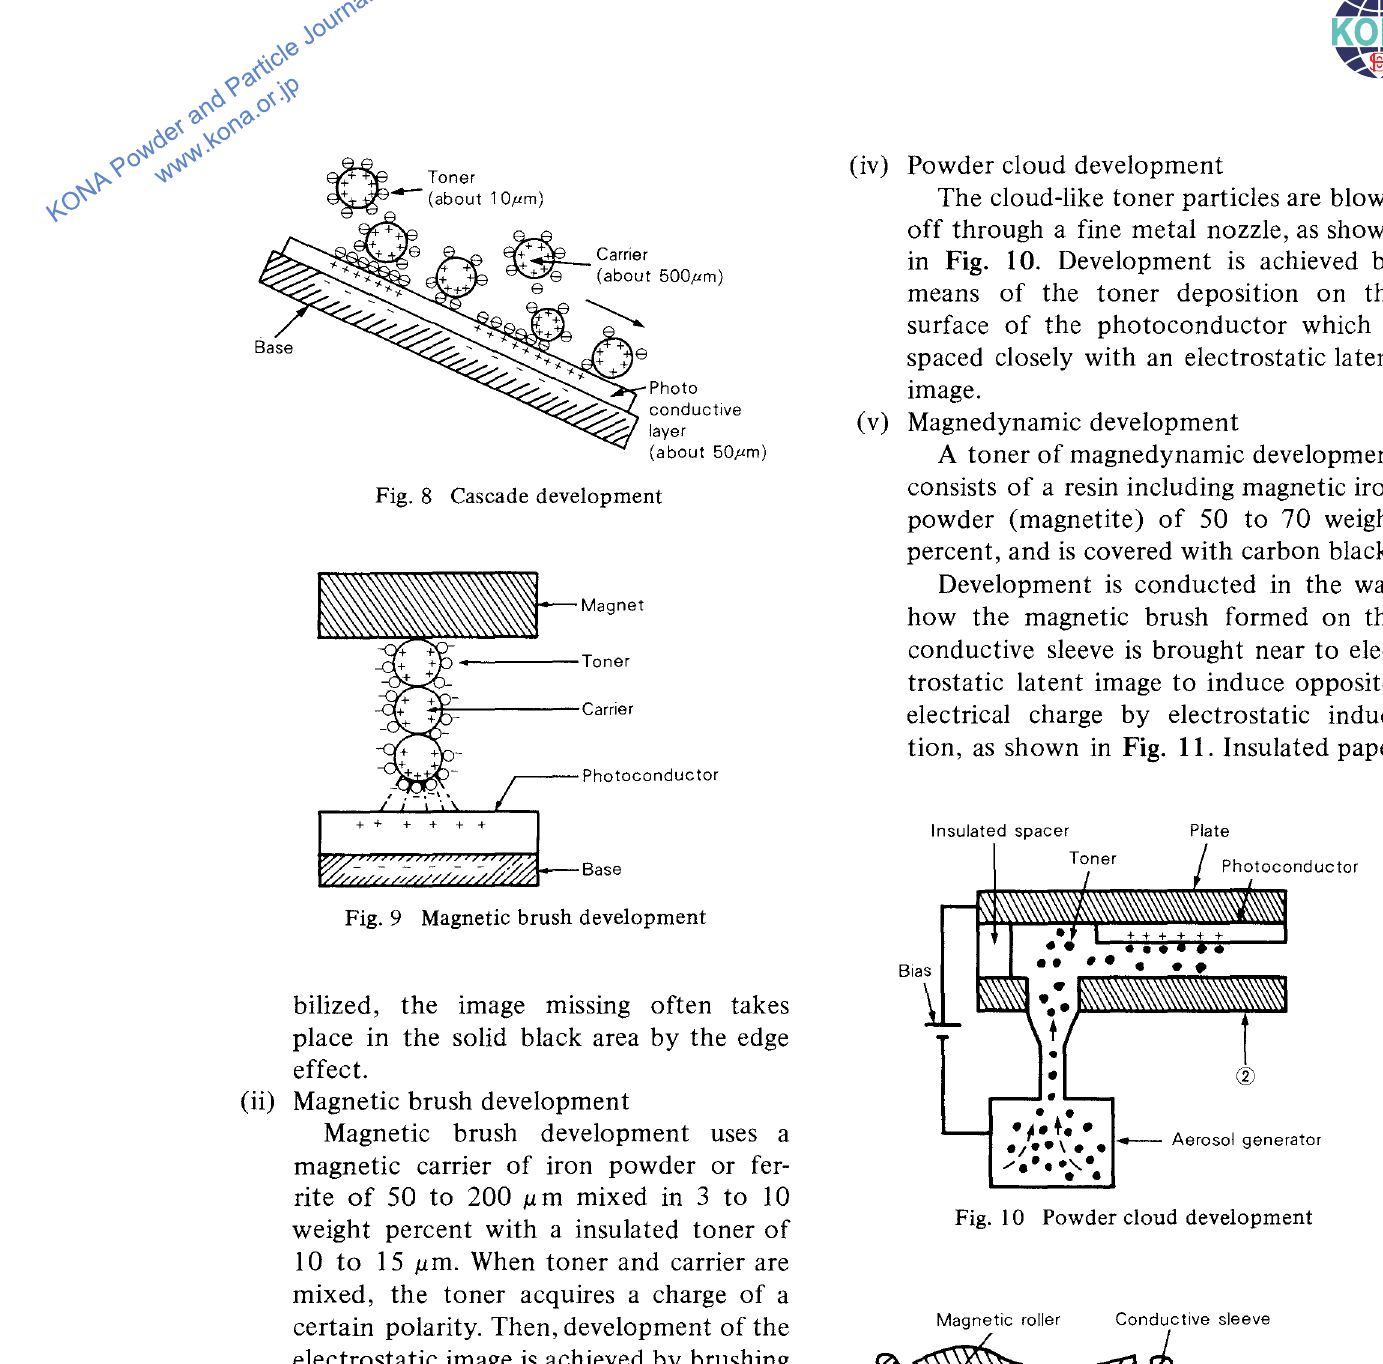
Fig. 1 0 Powder cloud development